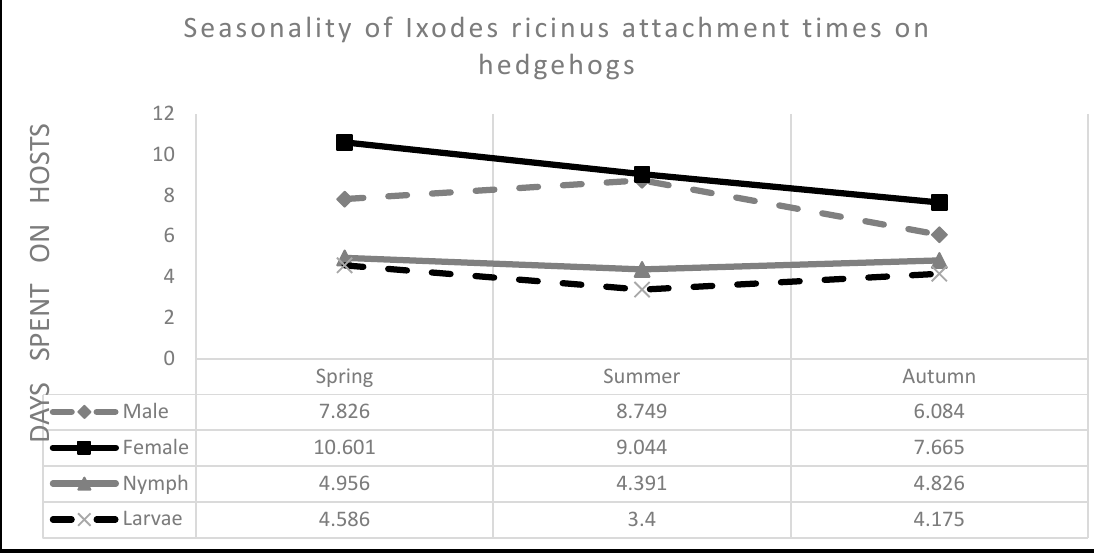
Figure 2. Seasonality of Ixodes ricinus a tt achment times on hedgehogs.